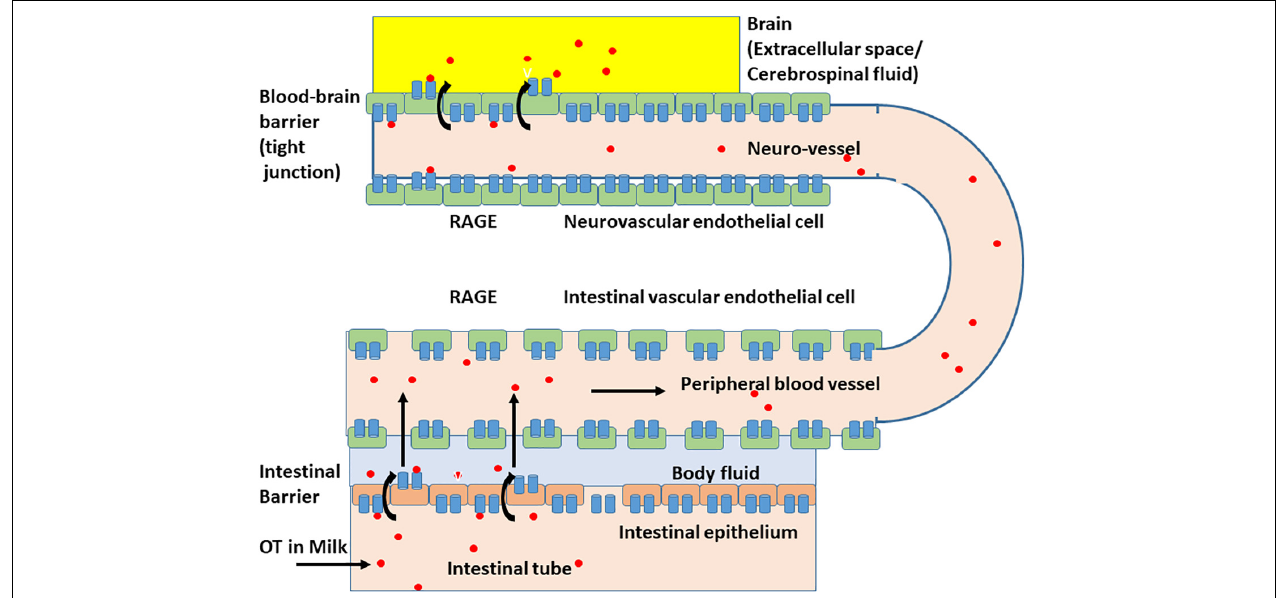
FIGURE 3 | Schematic representation of the oxytocin transport by membrane RAGE (mRAGE) across the intestinal and blood-brain barriers. (Lower) Milk-born or synthetic oxytocin (red circles) in the lumen of the small intestine is transported by mRAGE in intestinal epithelial cells first to body fluid (light blue) and then to blood in (intestinal) blood vessels with no or little barrier. In the lumen of blood vessels, oxytocin (OT; red circles) binds to mRAGE (blue). (Upper) mRAGE and OT interact with each other and internalizes to endothelial cells in small neurovascular vessels at the BBB to the extracellular space or CSF (yellow). The detailed mechanism for transport is not yet known, and OT is likely transported by